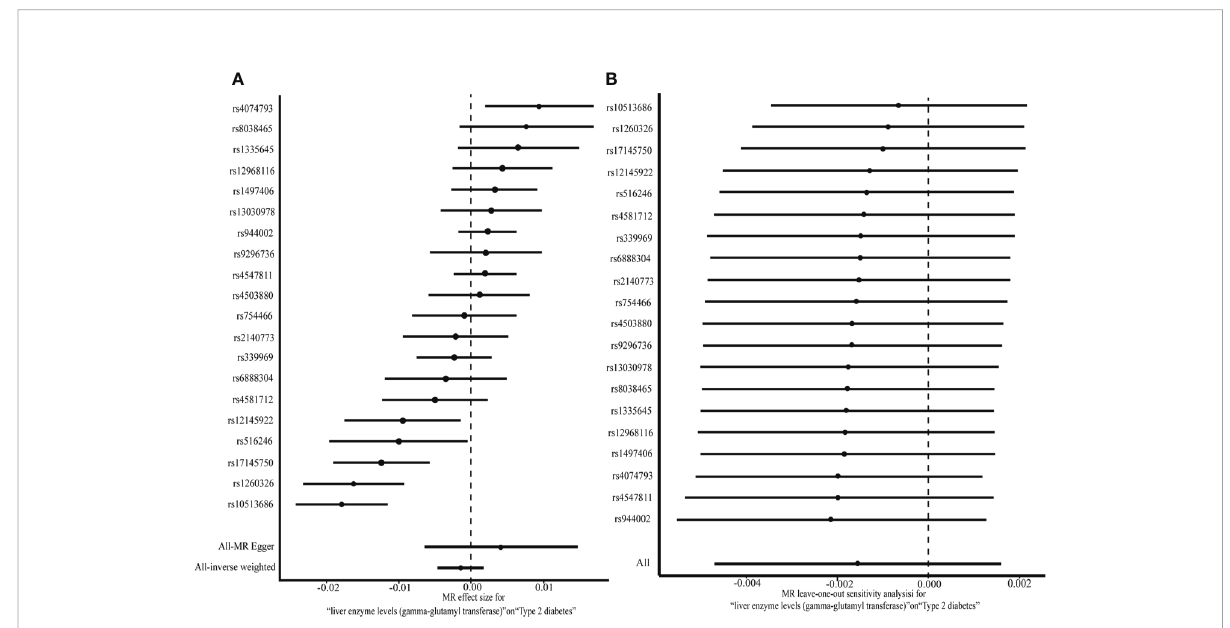
FIGURE 2 A two-sample MR analysis of the effect of GGT on T2DM (A) and MR leave-one-out analysis for GGT on T2DM (B)